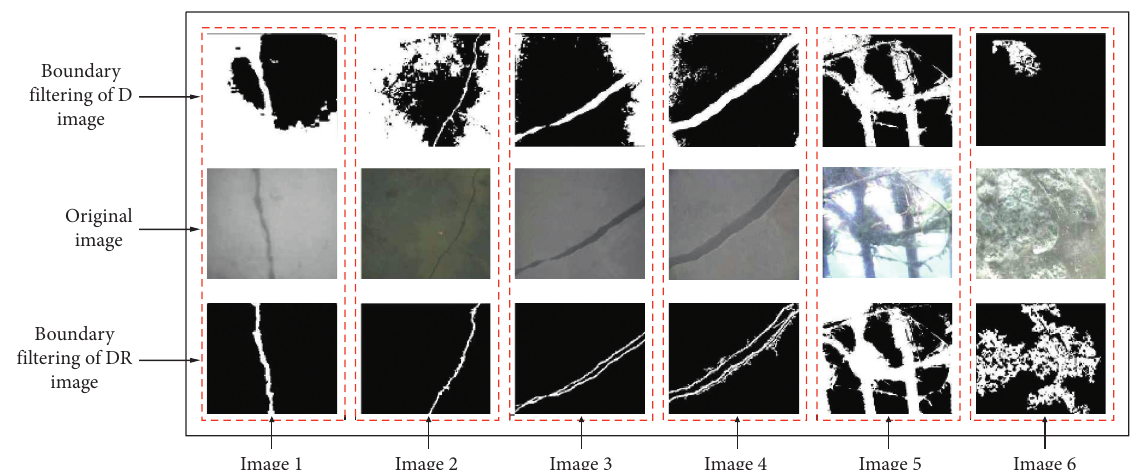
Figure 8: Comparative analysis of the filtering effect of the image after the defogging of the dark channel and the image processed by the DR